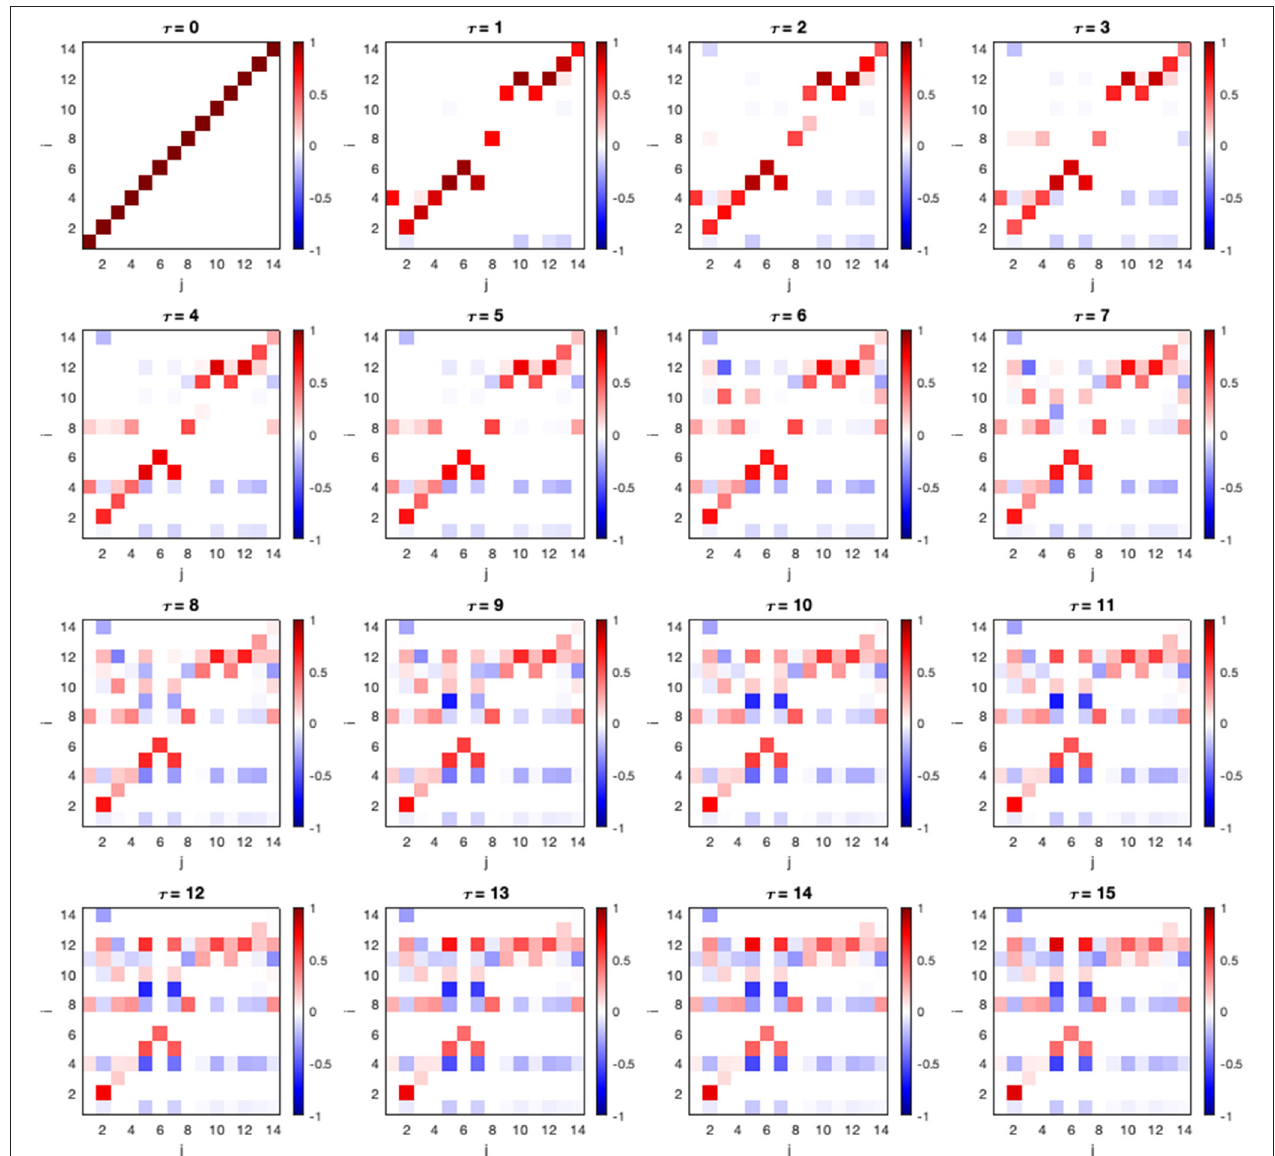
FIGURE 3 | Causal effect of all ROI pairs and lags. An entry in the matrix shows causal effect I CE i → j ( τ ) calculated using Equation (12) where i and j correspond to the ROI listed in Table 1 . The strength declines in the longer